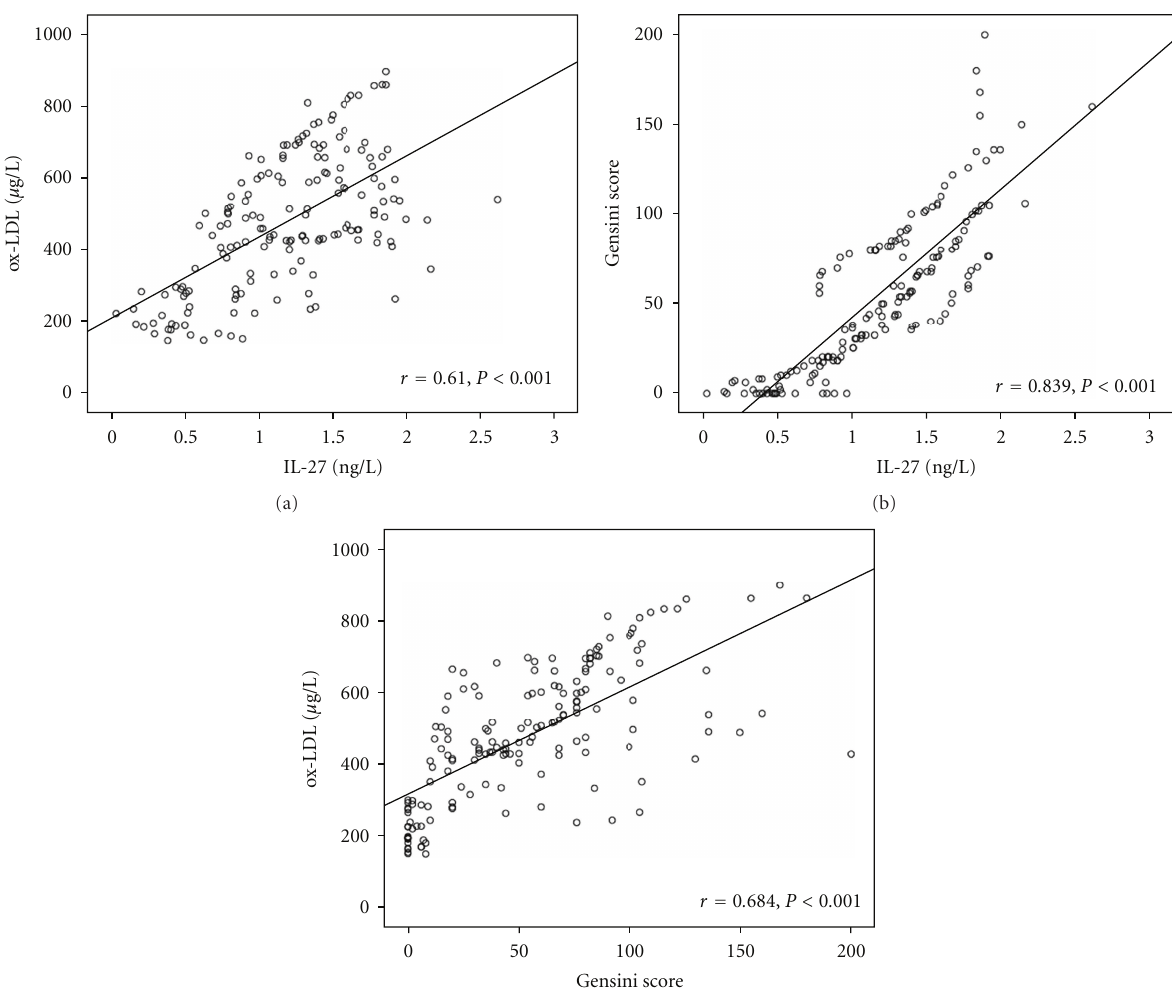
Figure 1: Correlation analysis of circulating levels of IL-27, ox-LDL, and Gensini score in the overall population. Circulating levels of IL-27 were positively correlated with ox-LDL (a), Gensini score (b); Circulating levels of ox-LDL were positively correlated with Gensini score (c). r : correlation coe ffi cient. Table 2: Circulating IL-27, ox-LDL, and Genisi score of subjects in each group. Control SAP UAP AMI P ox-LDL ( μ g/L) 212.310 ± 48.990 356.810 ± 84.867 a 539.240 ± 95.205